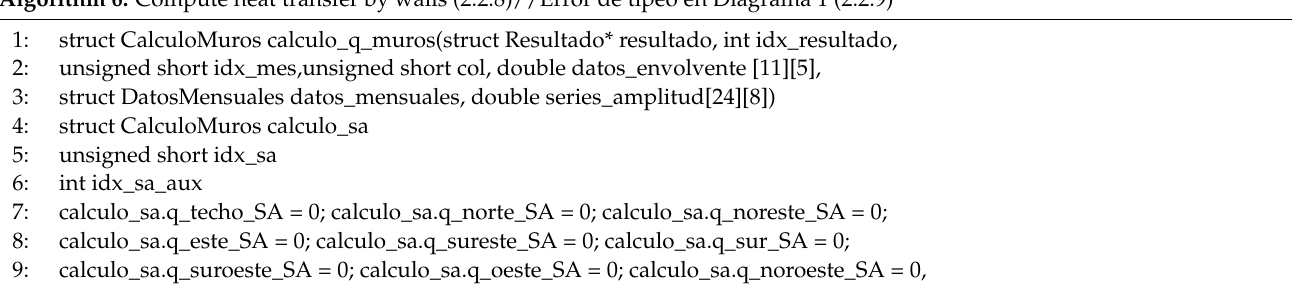
Algorithm 6. Compute heat transfer by walls (2.2.8)//Error de tipeo en Diagrama 1